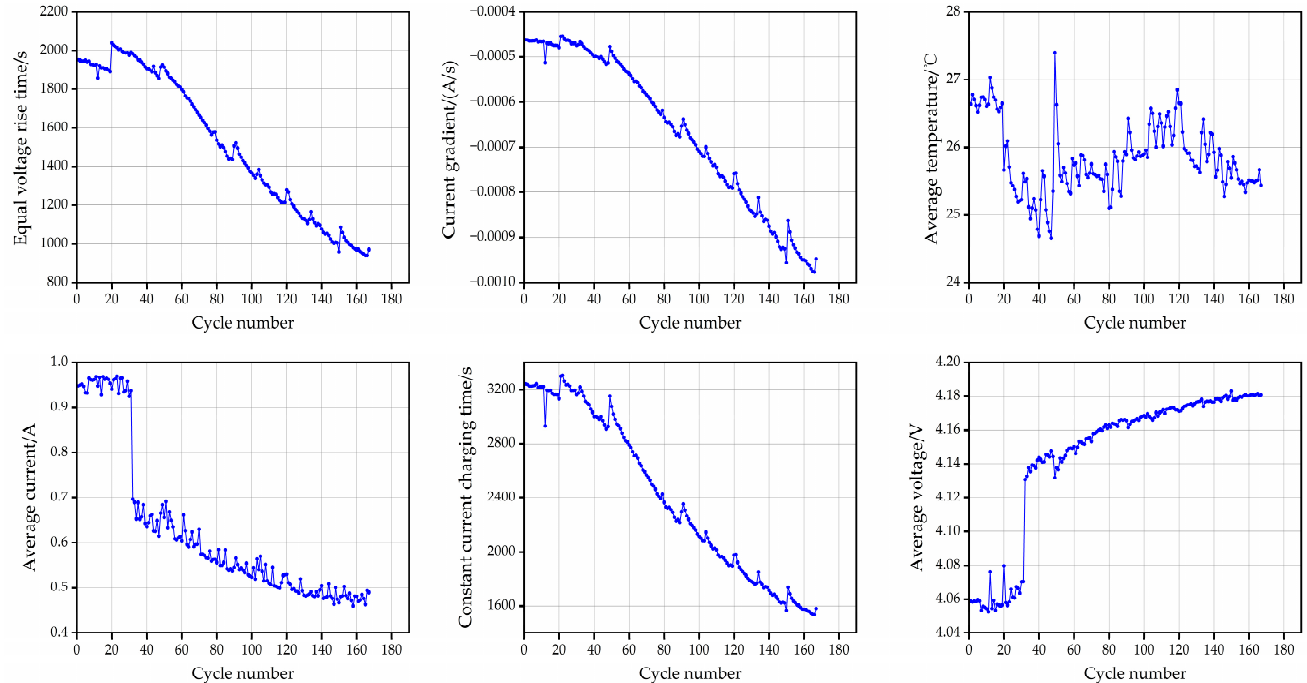
Figure 3. Relationship between HIs and battery charge cycles.